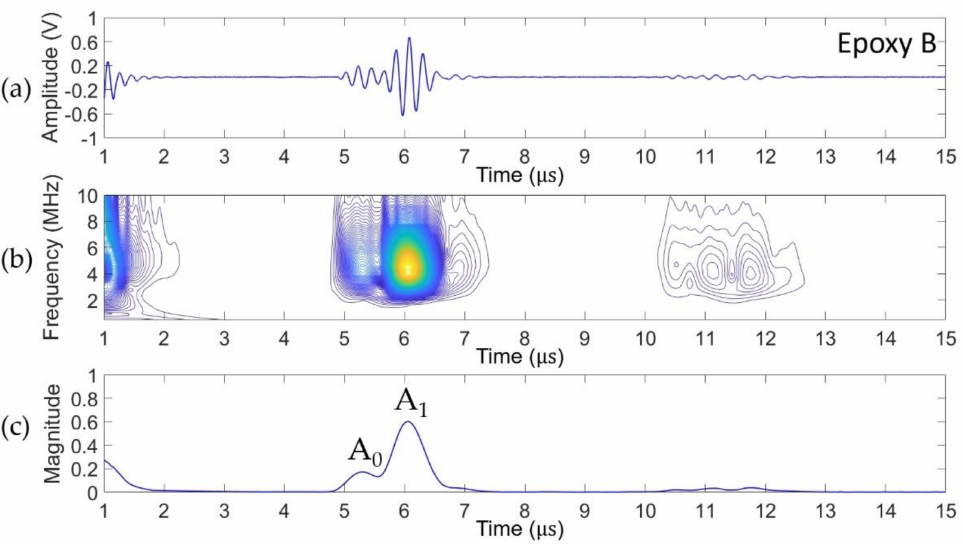
Figure 11. Debonded layer of epoxy B coating: ( a ) time-domain waveform, ( b ) spectrogram, and ( c ) the STFT magnitude